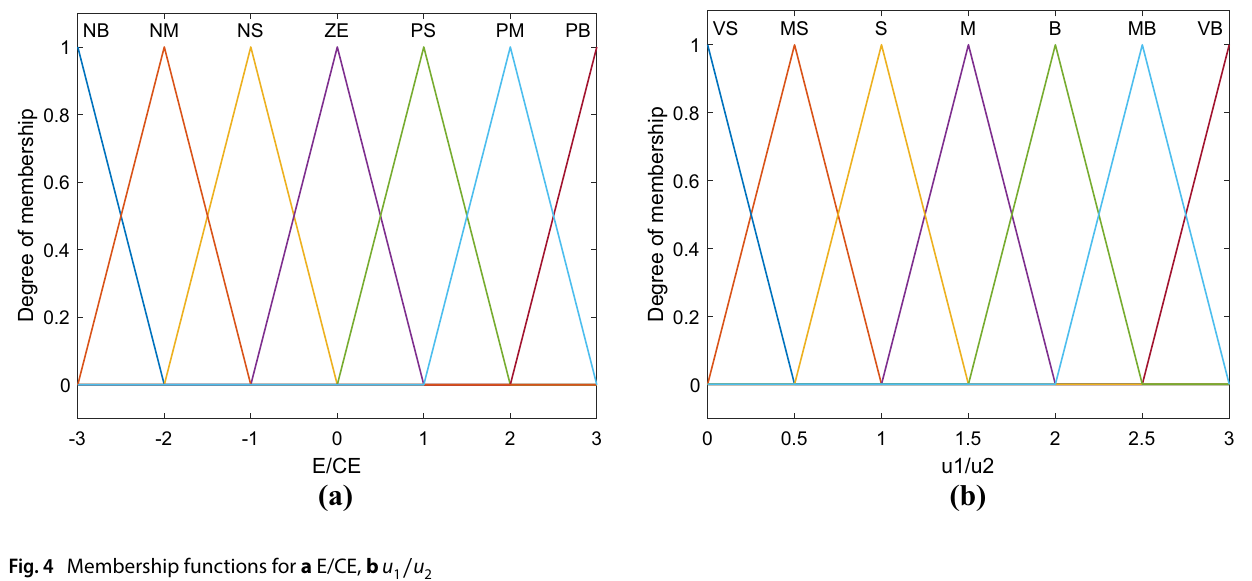
Fig. 4 Membership functions for a E/CE, b u 1 ∕ u 2